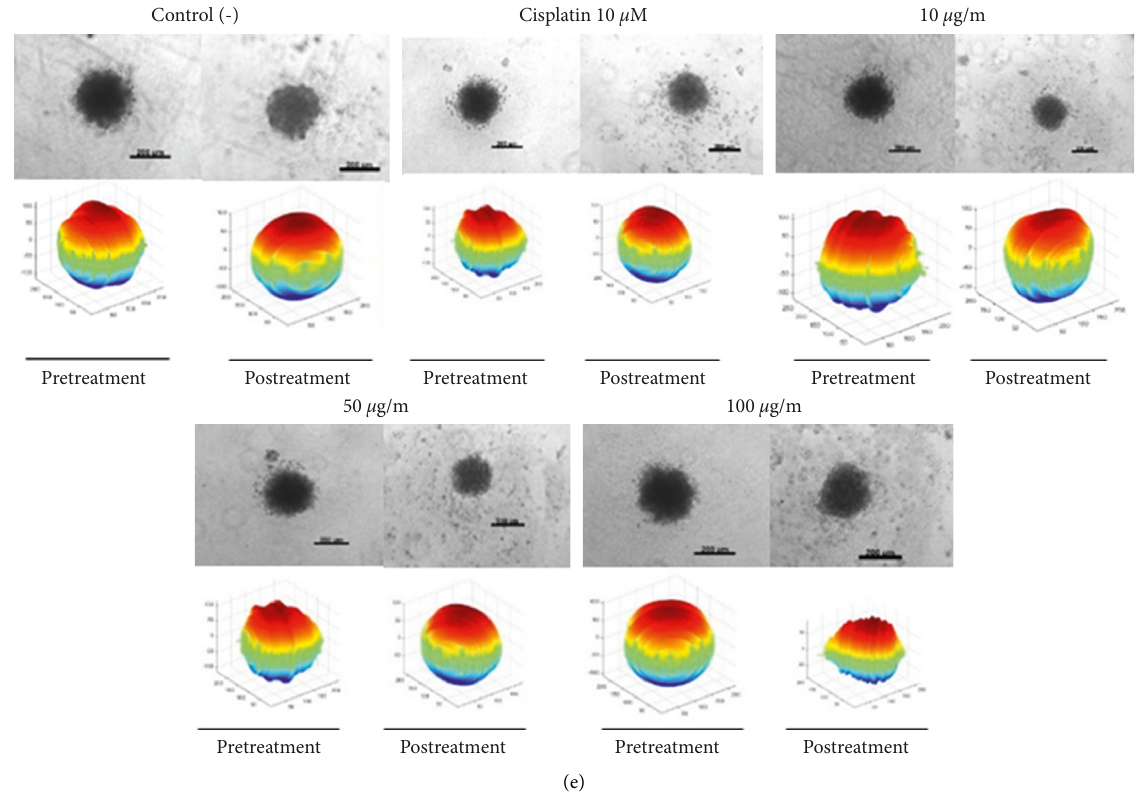
Figure 2: Spheroids of CAL 27 treated and untreated and their three-dimensional reconstruction. Box and Whiskers graphics show the most representative images of the spheroids’ morphological changes on parameters measurement before and after the PME treatment (10, 50, and 100 μ g/ml) and 20 μ M cisplatin 72h. (a) Sphericity. (b) Solidity. (c) Diameter. (d) Volume. (e) Inverted microscopy images of spheroids and its tridimensional reconstruction with AnaSP software show density color schematically with voxel localization within the three-dimensional image. Scale bar: 200 μ